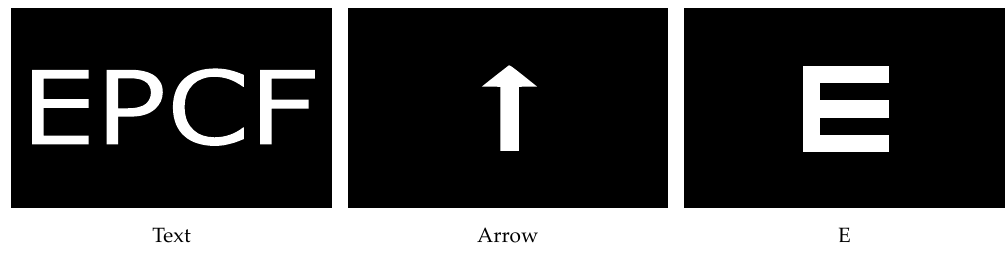
ff erent content types displayed by the eHMI in the present Figure 3. The three different content types displayed by the eHMI in the present study. Figure 3. The three di